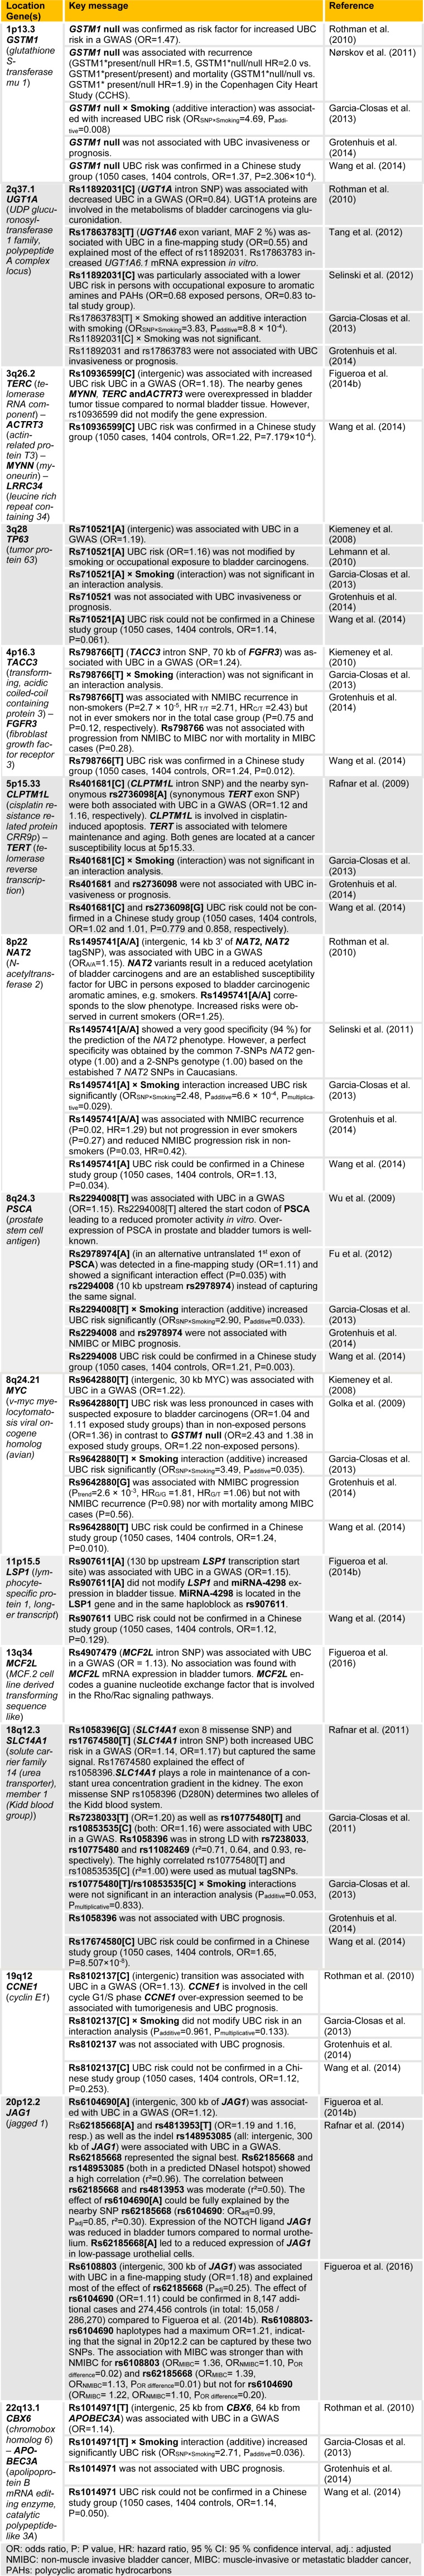
Currently confirmed polymorphisms that are associated with UBC risk, their association with bladder carcinogen exposure and prognosis (update of Selinski, 2014) according to Selinski (2014). Polymorphisms, associated genes and locations are printed in bold, risk alleles or genotypes are given in brackets.